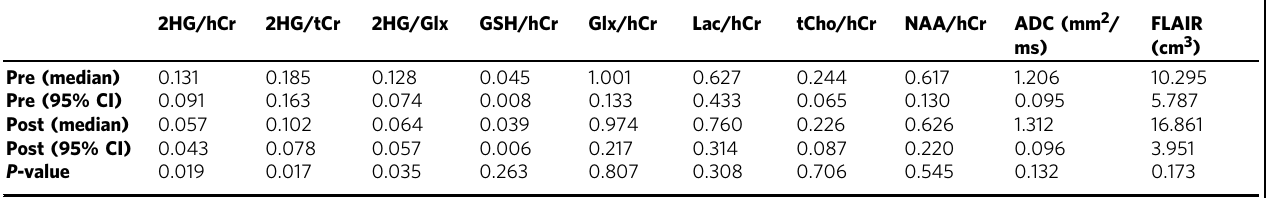
Table 2 Quanti fi cation of metabolites and imaging